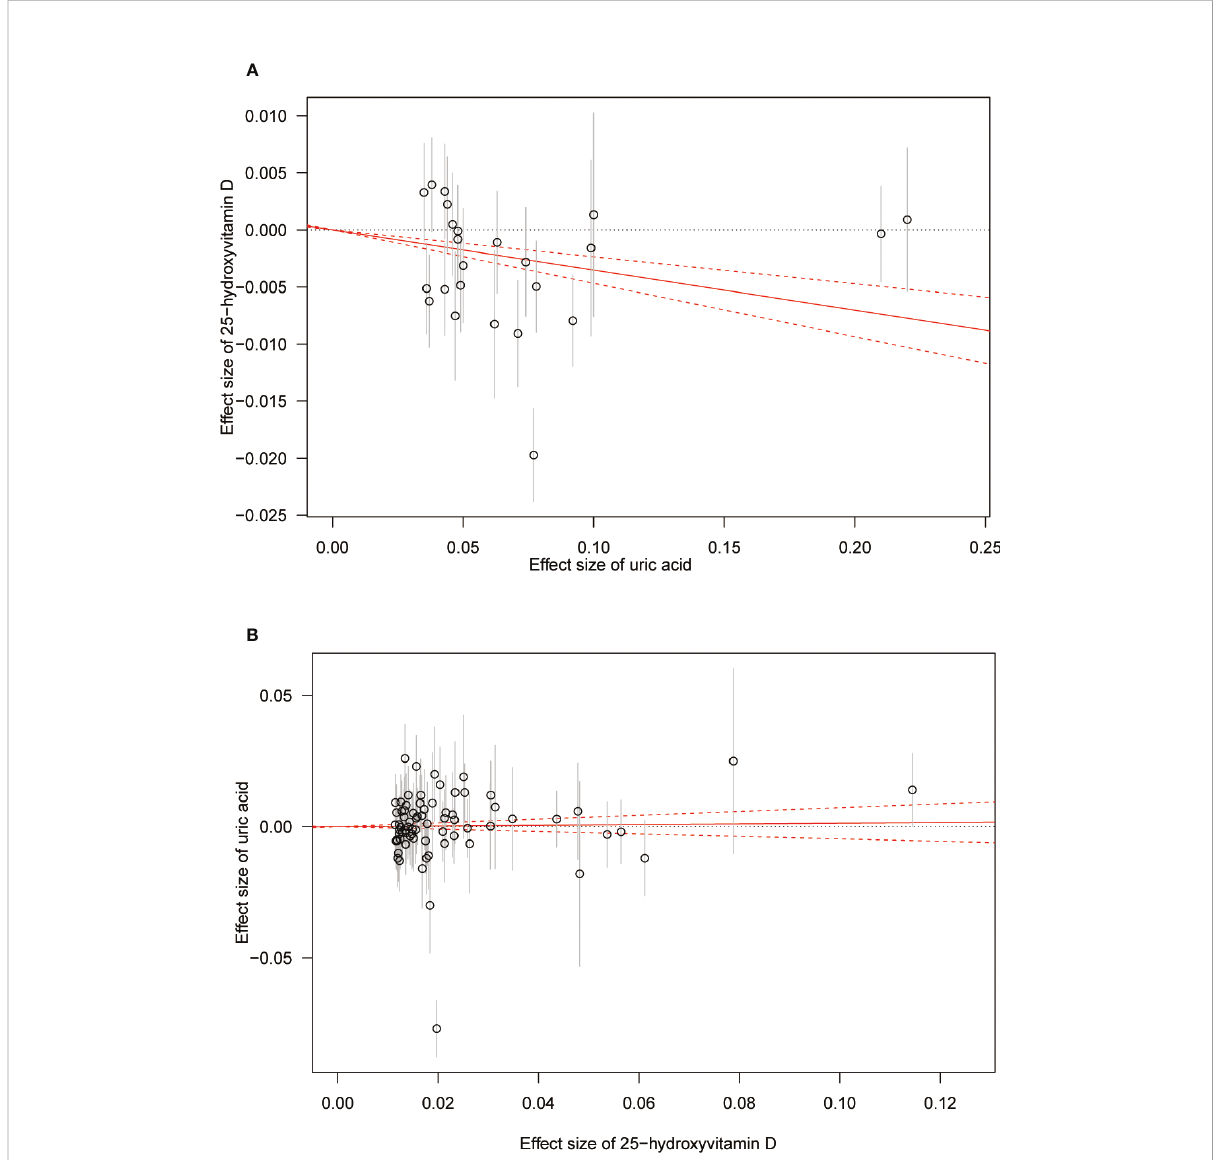
FIGURE 6 (A) Genetic risk score GRS SUA for 25-hydroxyvitamin D. (B) Genetic risk score GRS 25(OH)D for serum uric acid. The estimate of causal association is shown by a red solid line with gradient, and 95%CIs are denoted by red dashed